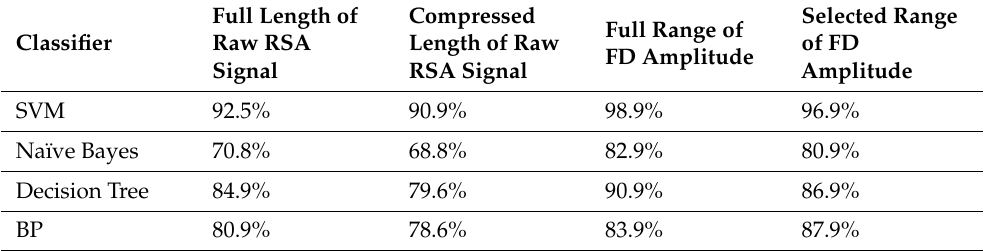
Table 8. Accuracy performance of different classifiers of interlaminar porosity defect using different source of training